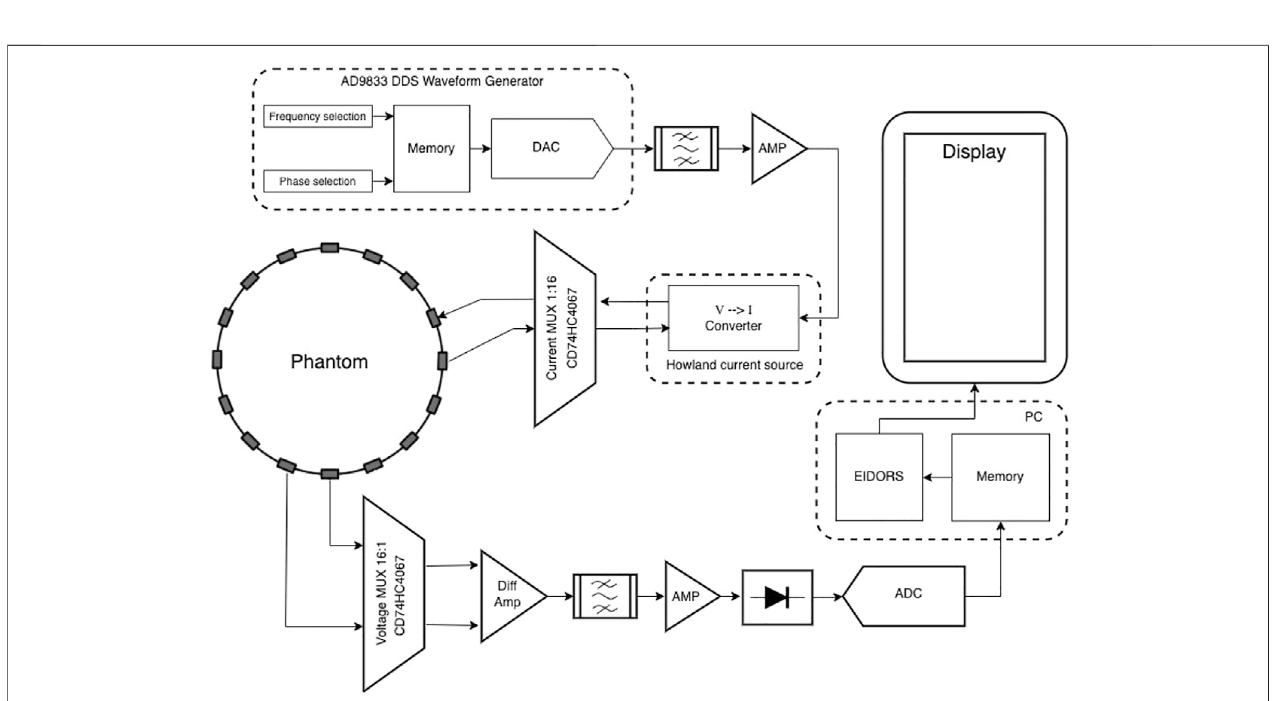
Frontiers in Electronics |